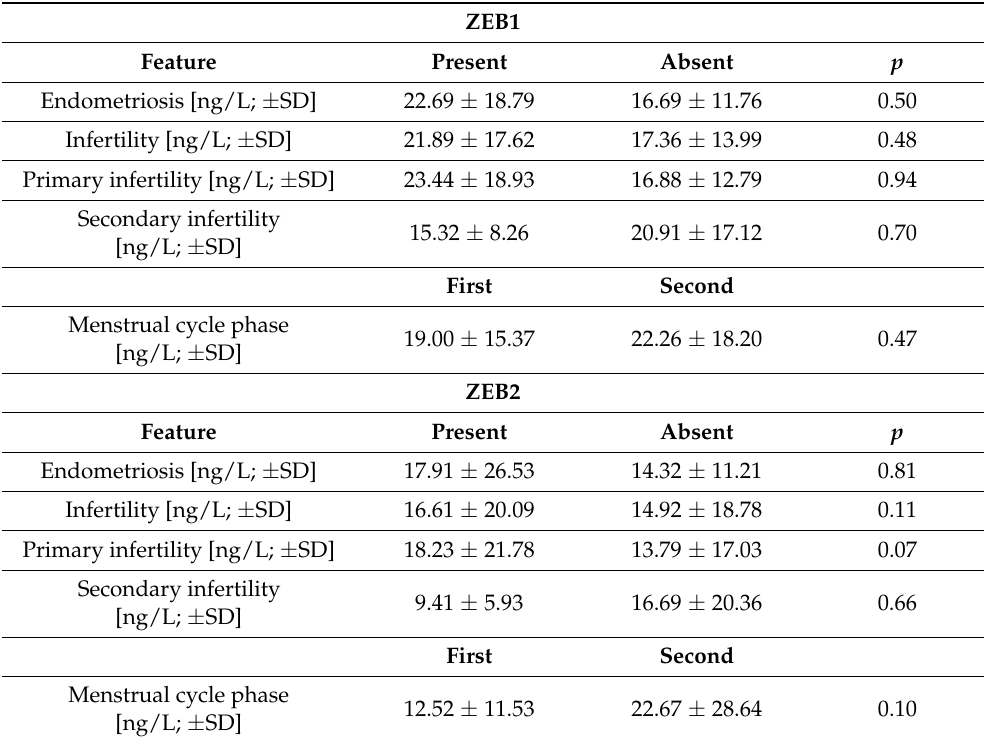
Table 3. Zinc finger E-box-binding homeobox 1 (ZEB1) and Zinc finger E-box-binding homeobox 2 (ZEB2) concentrations in the peritoneal fluid.